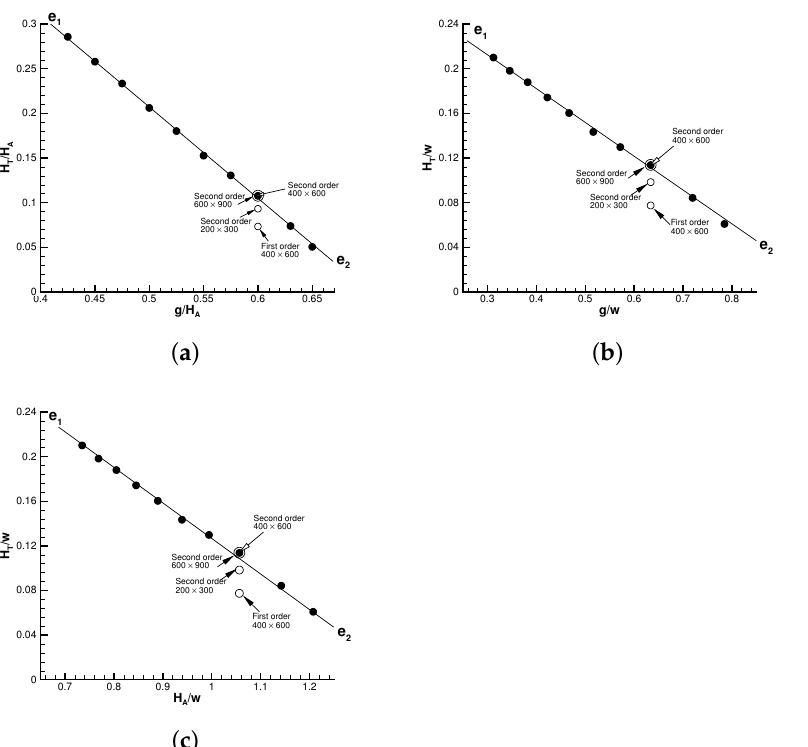
Figure 3. Numerical results for normalized Mach stem heights as a function of the normalized wedge trailing edge height for M 0 = 4 and θ w = 25 ◦ : ( a ) H T The line e 1 e 2 is a straight line passing through the CFD data. Open circles are CFD data obtained using grids different to 400 × 600 points or a first-order accurate